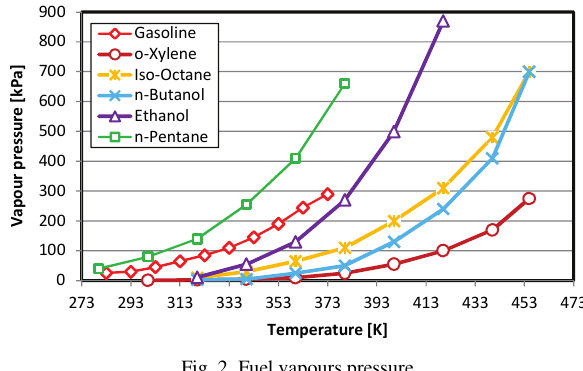
Fig. 2. Fuel vapours pressure